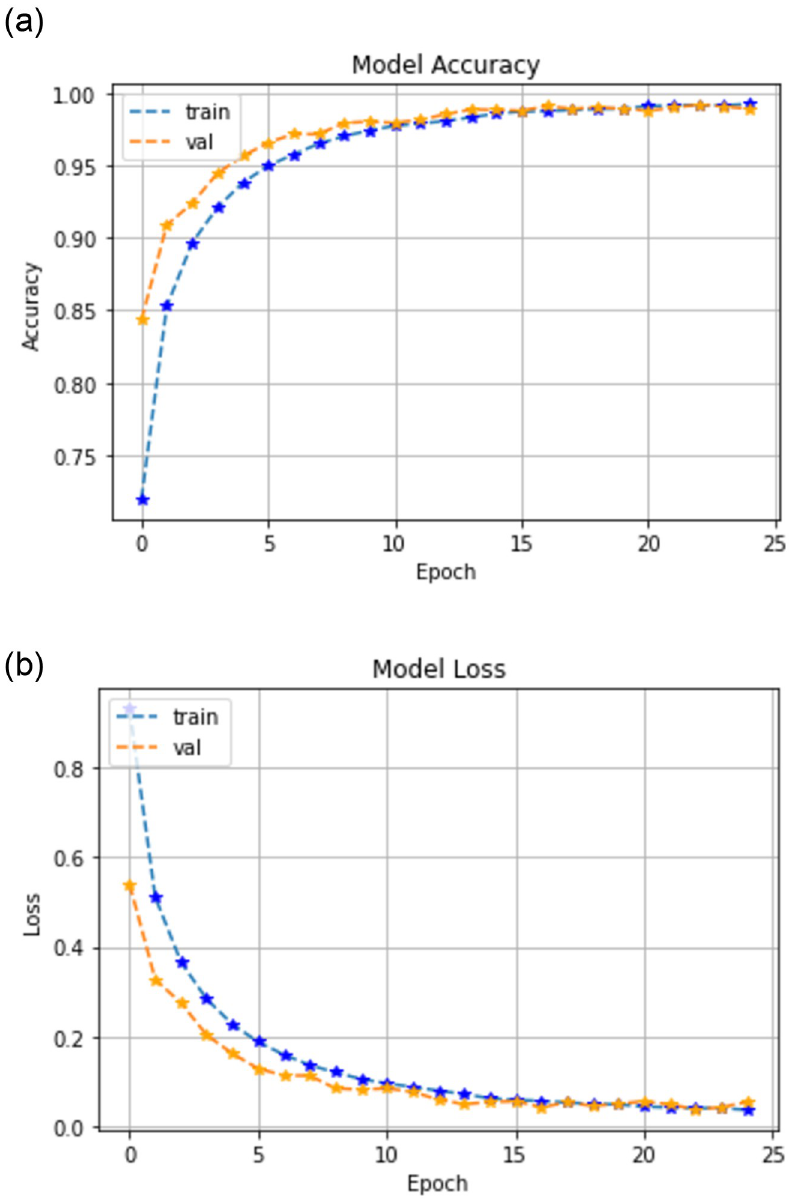
Fig 7. Model accuracy and model loss for fused planet-scope and Sentinel-2